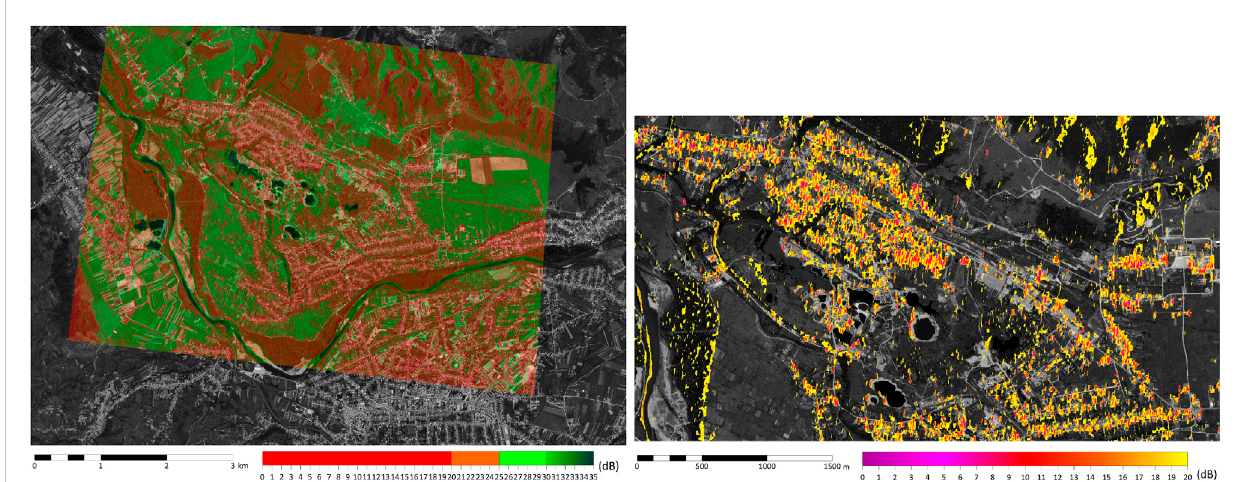
FIGURE 13 ExpectedSCRfromDescendingTrackNo.7usinglast-yearSentinel-1acquisitionsforestimation(202012-202112),markedcriticalnon-usageareas with SCR < 20